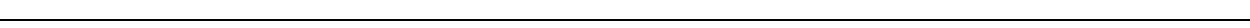
by the structure-speci fi c RAD1 – RAD10 endonuclease 17,57 . ERCC1 in mouse embryonic stem cells 15 or in human U2OS cells (Fig. 6a) did not noticeably affect the frequency of alt-NHEJ.